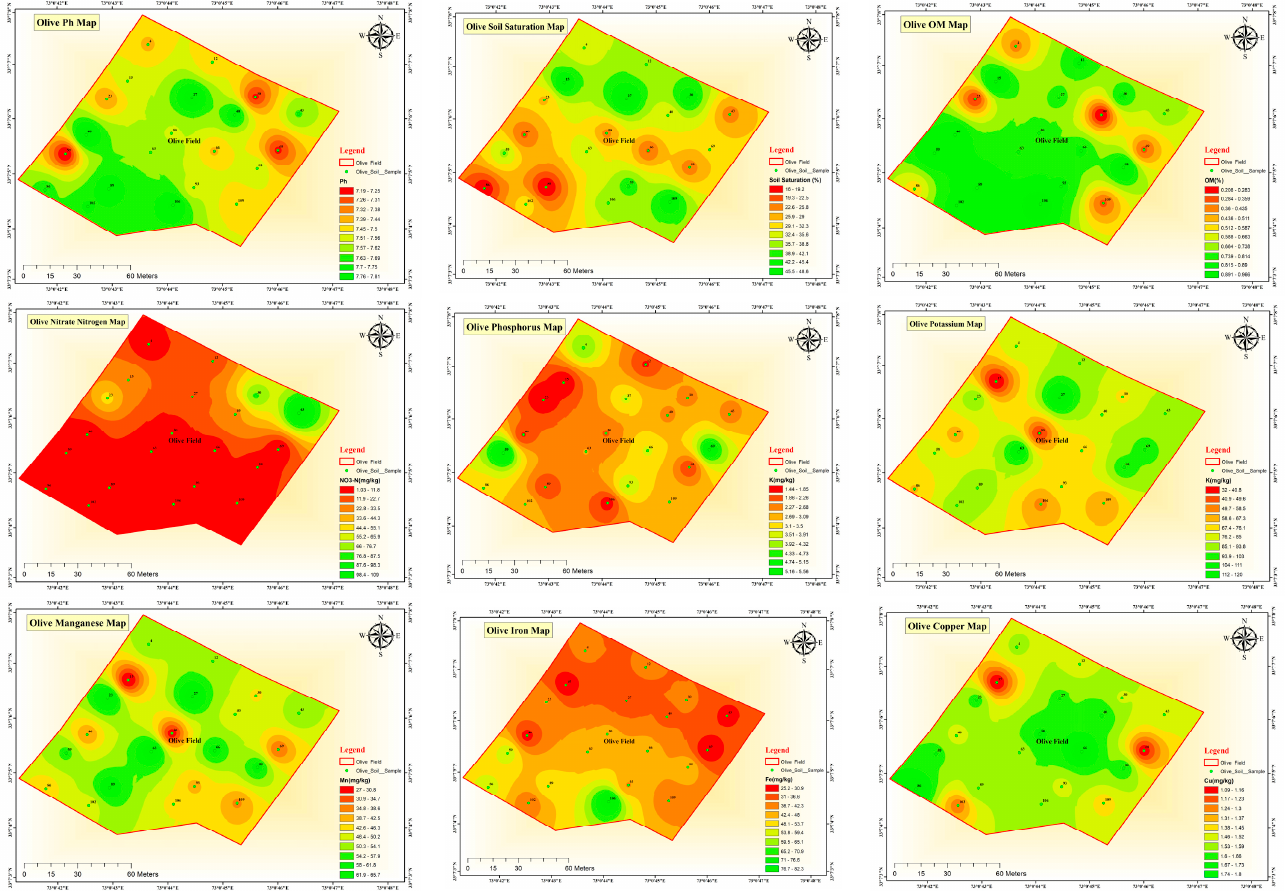
Figure 1. GIS maps showing status of different soil porperties and nutrients in the olive orchard.